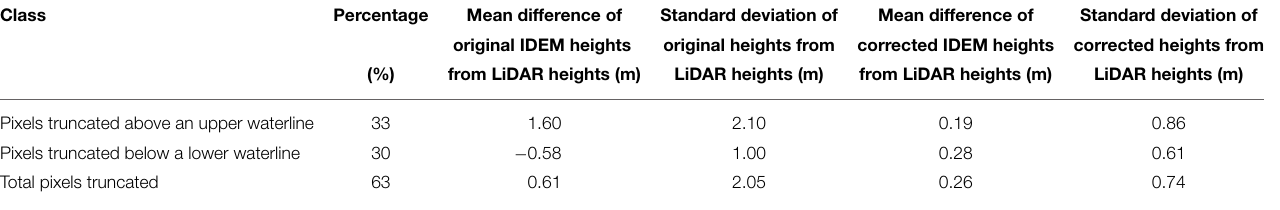
TABLE 2 | Correction of truncated IDEM pixel heights and errors between the